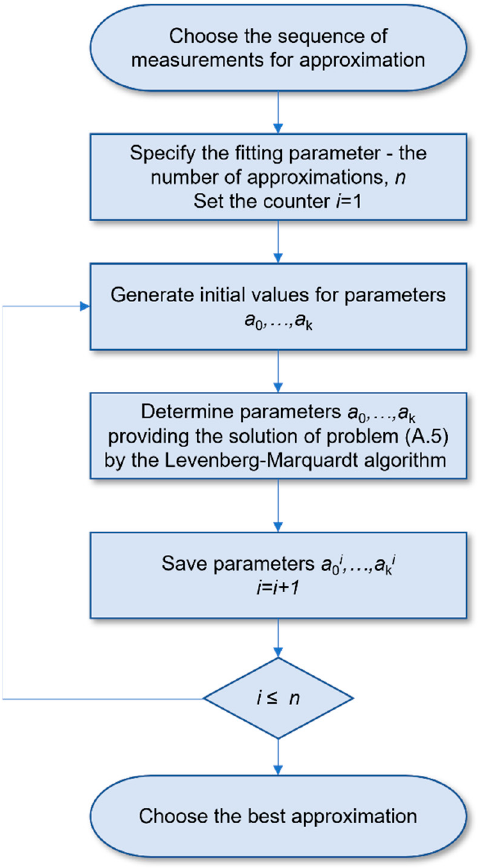
Figure A2. The procedure for building an approximation.